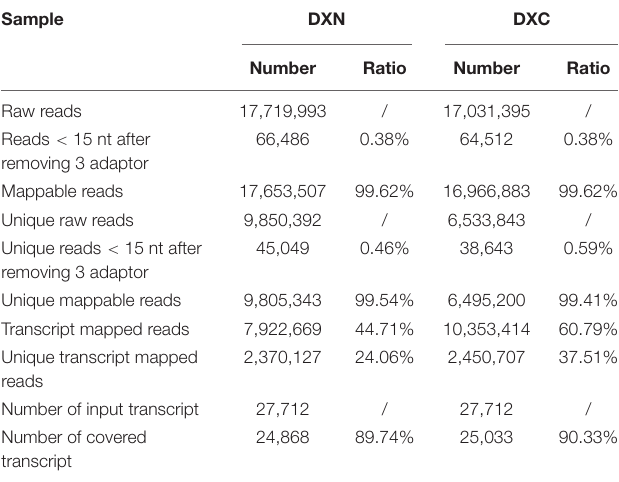
TABLE 1 | Summary of the degradome sequencing data in DXN and